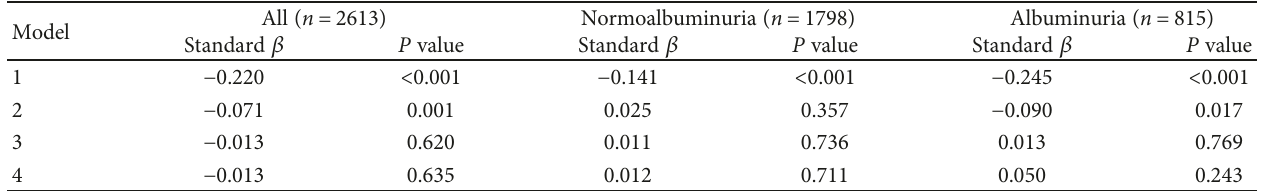
Table 4: Multivariate regression analyses with eGFR as a dependent variable and baPWV as an independent variable.